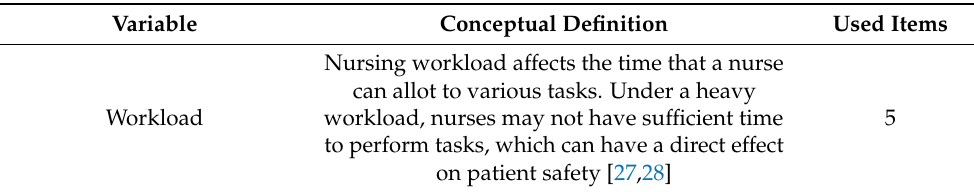
Table 2. Other factors affecting healthcare